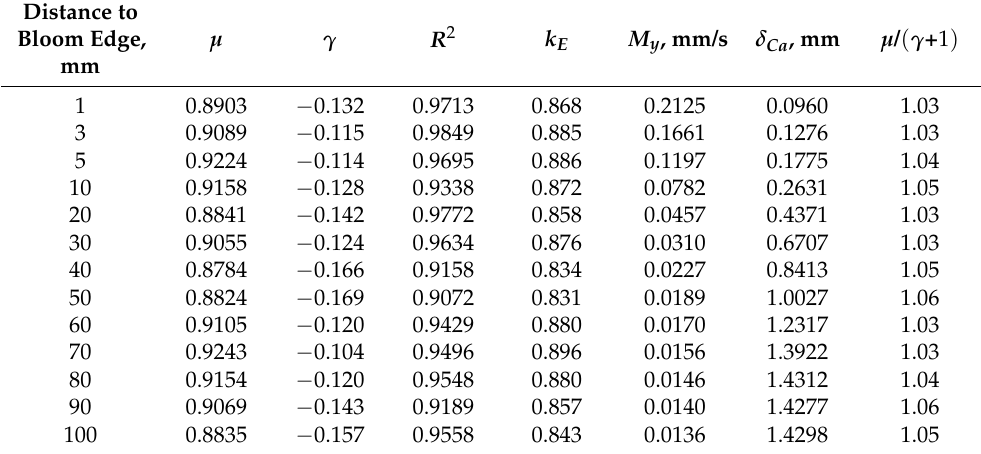
Table 2. Fitted and calculated results in the inner curve side under 20 ◦ C ( µ , γ are fitted coefficients in Equation (3), and R 2 is the corresponding determination coefficient. k E is the effective solute redistribution coefficient. M y is growth velocity magnitude in the solidification unit along the measuring line at each position. δ Ca is the average thickness of the concentration boundary layer). Distance to Bloom Edge,